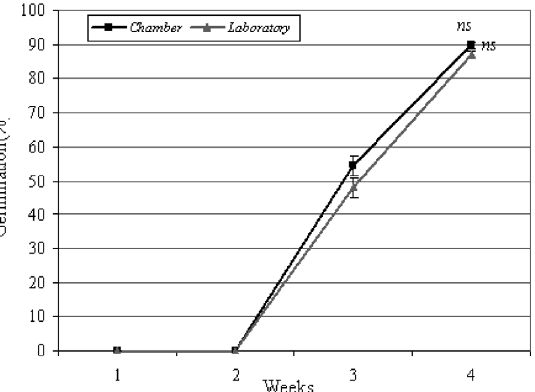
, days) in the two experi- 50